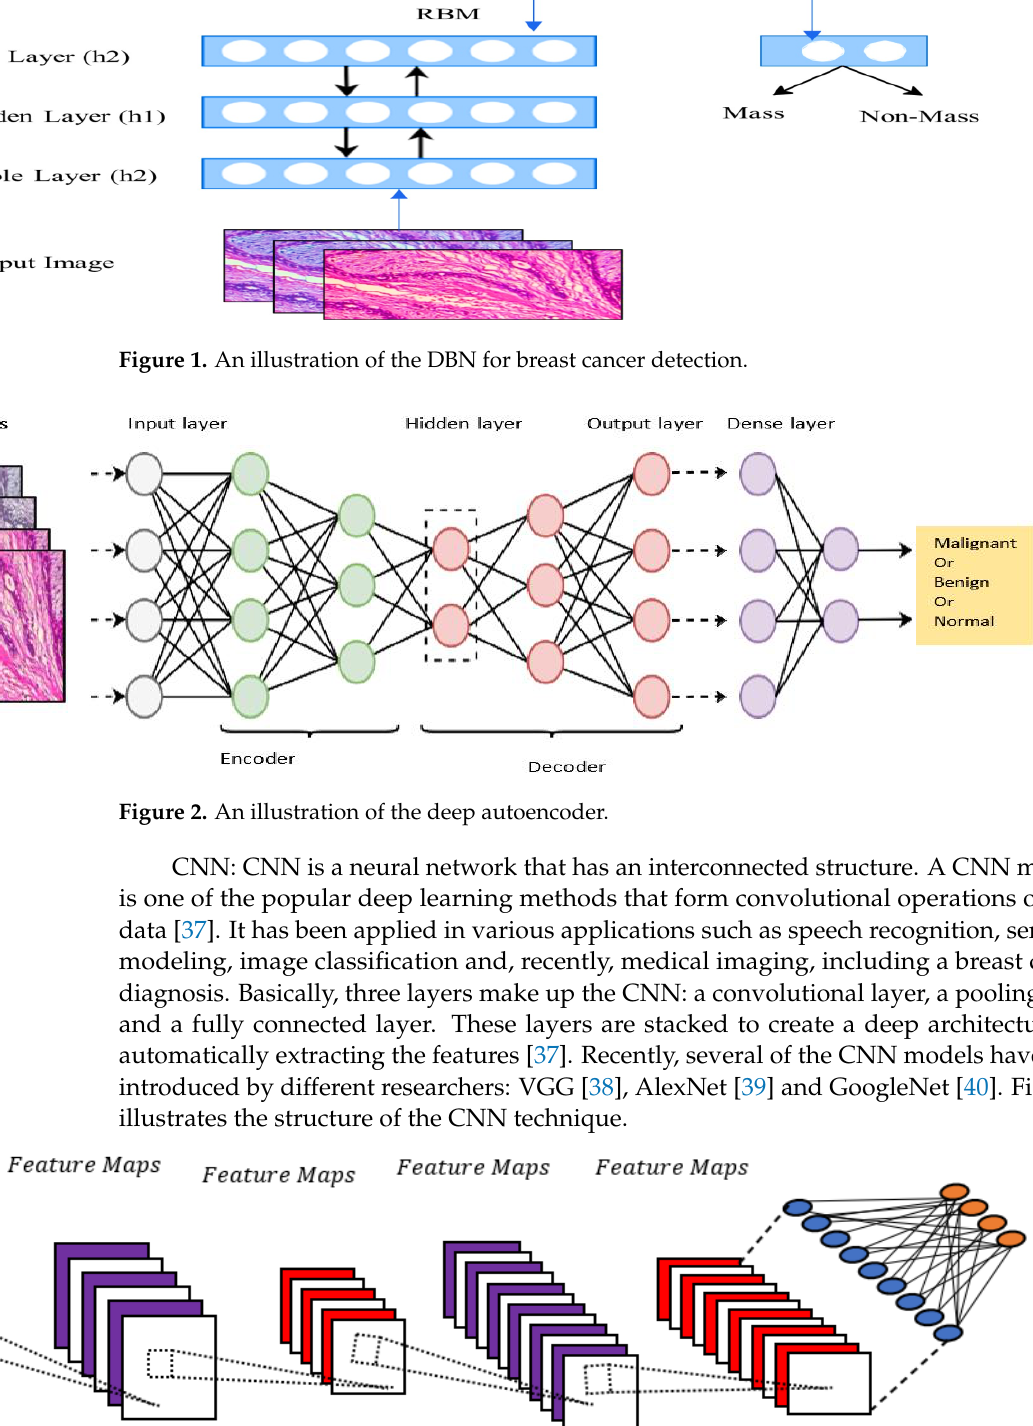
Figure 3. An illustration of the CNN